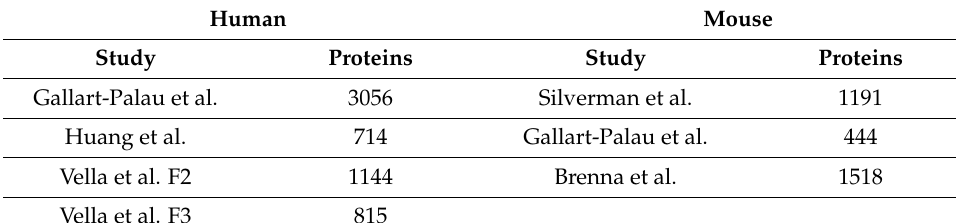
Table 1. Total protein IDs identified in human and mouse studies. Note that there is a slight difference in protein numbers published in the referred papers and in Table 1. This is due to our strategy to use gene names and convert them to Uniprot-reviewed accessions as described in Material and Methods.